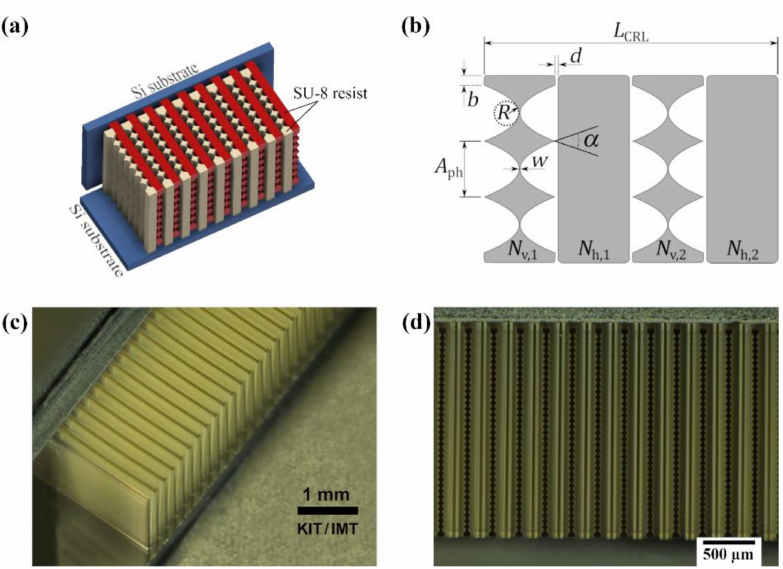
Figure 2. 2D biconcave parabolic polymer (SU-8) multi-lens array for 34 keV fabricated by deep X-ray lithography and mechanical assembly: ( a ) 3D model of two interdigitated planar compound refractive lenses (CRLs) on the silicon substrate (blue) with vertically focusing lens elements (red) and horizontally focusing lens elements (beige). ( b ) The design parameters are A ph —physical aperture, N v and N h —number of lens elements in the vertical and in a horizontal directions, respectively, R —radius of curvature, d —air gap, α —angle between adjacent parabolas, w —web distance, b —rectangular parts at the edges for stabilizing the single lens arrays, L CRL —total length of the multi-lens array. ( c ) Optical microscope image of the fabricated 34 × 34 multi-lens array and ( d ) top